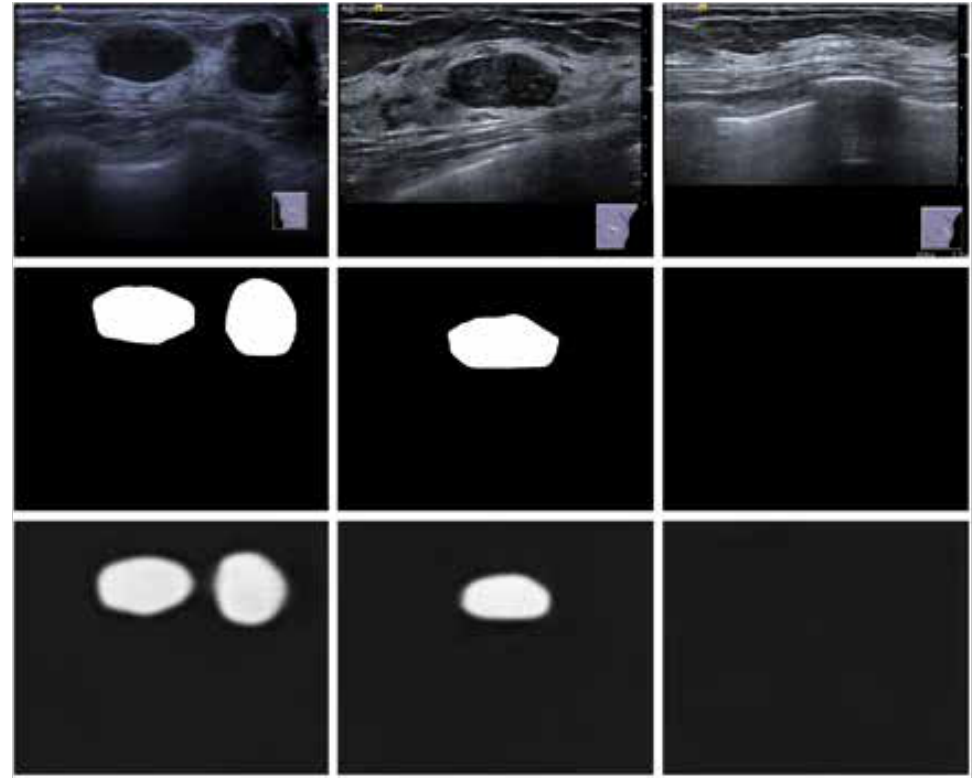
Figure 6 Segmentation probability maps of breast images generated by pre-trained convolutional neural network (PCNN). Typical cases of breast nodule and normal breast images are shown in the first row; manually delineated ground truth masks and the segmentation probability maps generated by the PCNN are shown in the second and third rows,